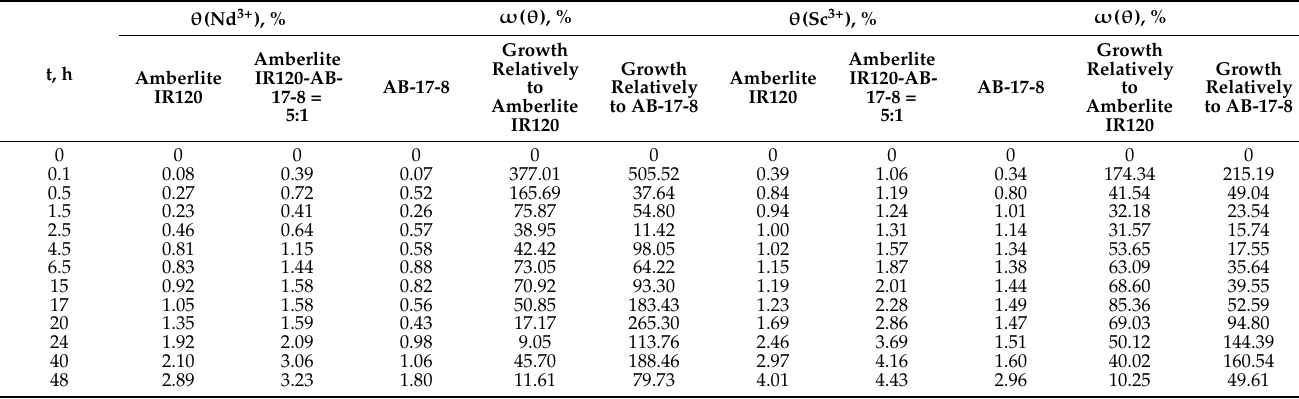
Table 2. Increase of polymer chain binding degree (in relation to Nd 3+ and Sc 3+ ions) in interpolymer pair Amberlite IR120:AB-17-8 = 5:1 comparatively with individual ion-exchange resins. θ (Nd 3+ ), t, h